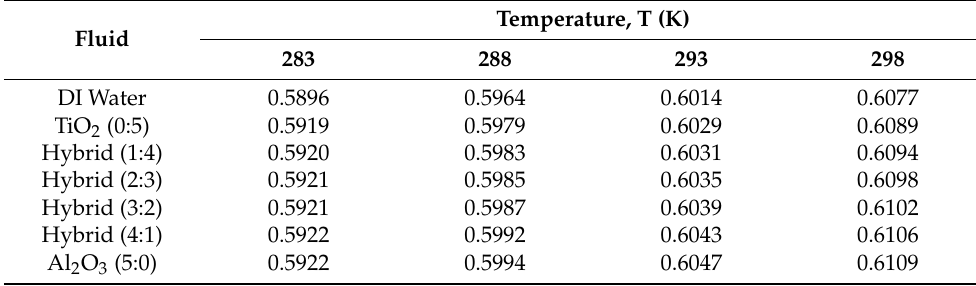
Table 4. Thermal conductivity of hybrid nanofluids at different temperatures and particle